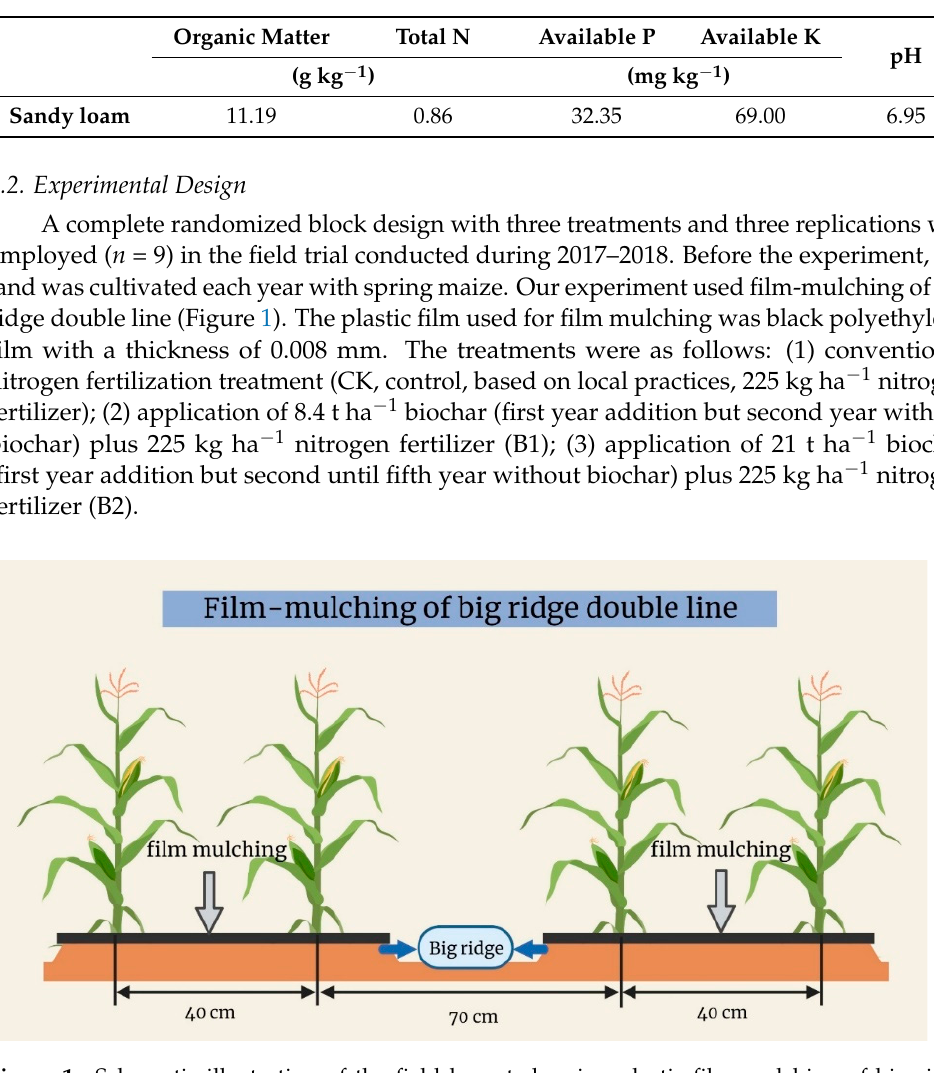
Figure 1. Schematic illustration of the field layout showing plastic film mulching of big ridge double line. double